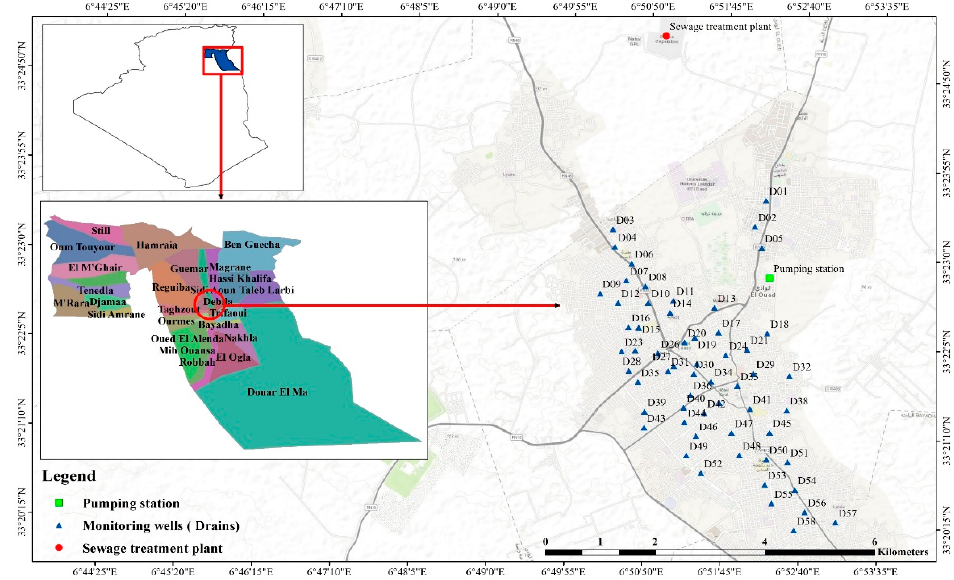
Figure 1. Location map of the study area exemplifying the distribution of the monitoring wells (drains of the vertical drainage system).